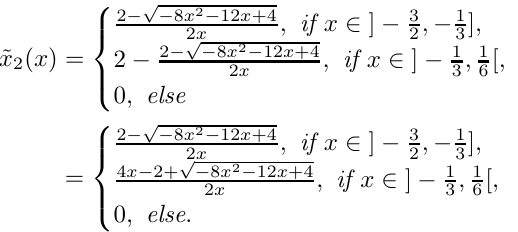
Fig. 5. The second parametric function, . f sym 2